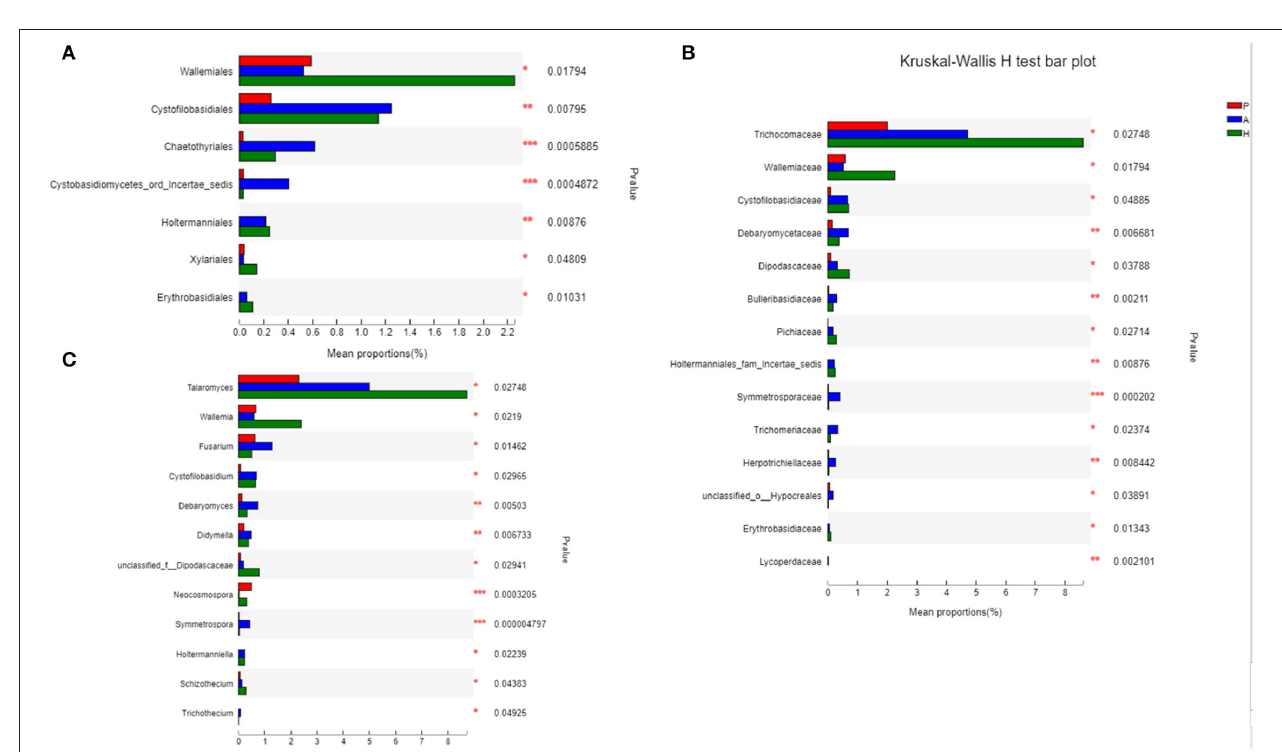
FIGURE 12 | Biomarkers of fungi in patients with Peutz–Jeghers syndrome (PJS) at different levels. (A) Biomarkers in PJS samples at the order level (Kruskal–Wallis H -test). (B) Biomarkers in PJS samples at the family level (Kruskal–Wallis H -test). (C) Biomarkers in patients with PJS at the genus level (Kruskal–Wallis H -test). * p < 0.05; ** p < 0.01; *** p < 0.001.